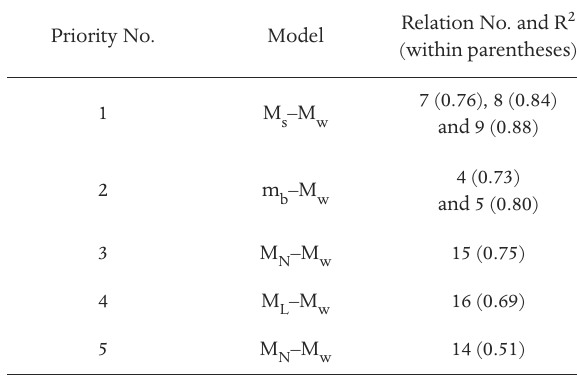
Figure 9. M –M conversion relations for Iran. Abbreviations as L w Figure 3.